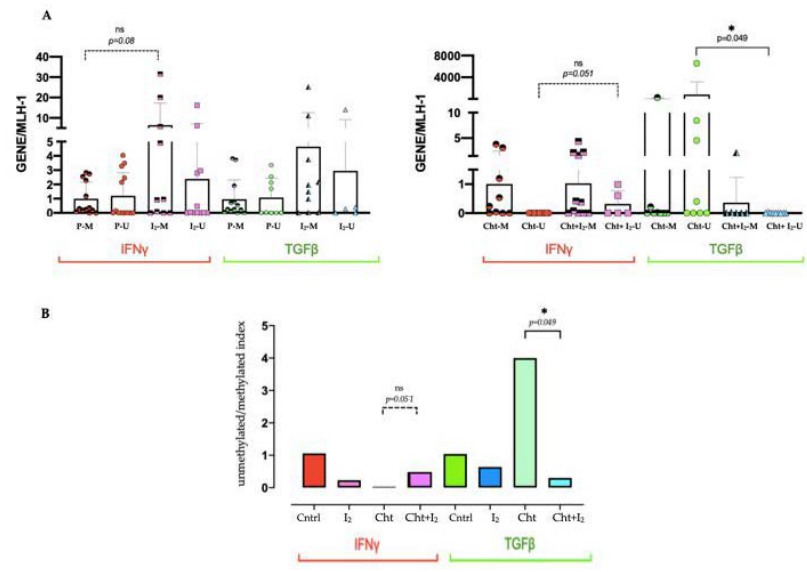
Figure 5. Methylation pattern of IFN γ and TGF β gene promoters. ( A ) Amplification of the promoters (qPCR) of Unmethylated (U) or Methylated (M) forms in individual samples. The quantification was normalized by the expression of the housekeeping gene MLH-1. Left panel stage II and right panel stage III. ( B ) Unmethylated/Methylated index (means division) of each gene. Cntrl, control; I 2, iodine; Cht, chemotherapy; Cht+I 2 , Chemotherapy plus iodine. Student’s t -test * p <